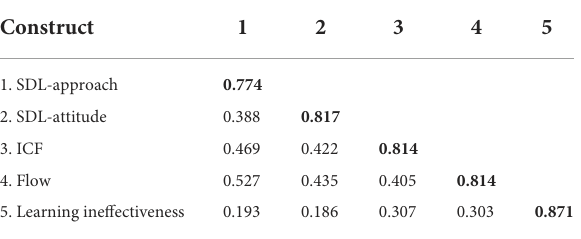
TABLE 2 Dimension discriminant validity